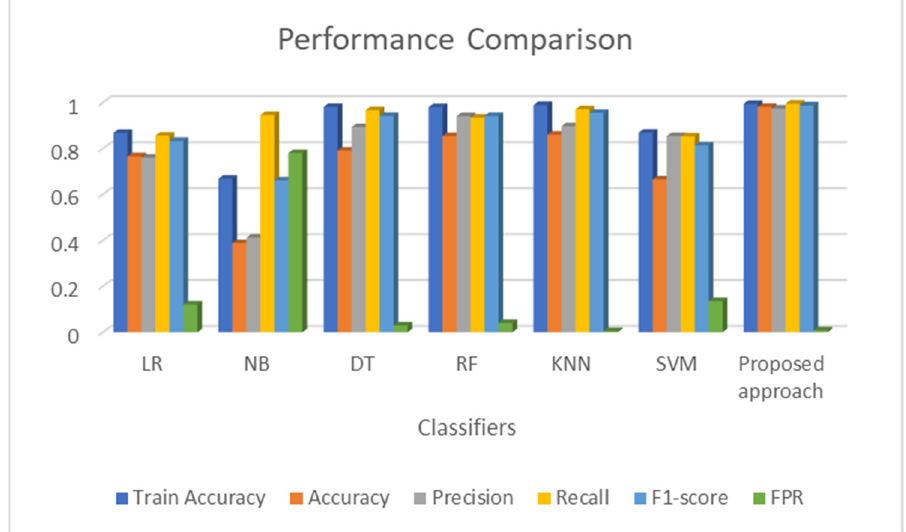
Figure 5. Performance comparison.